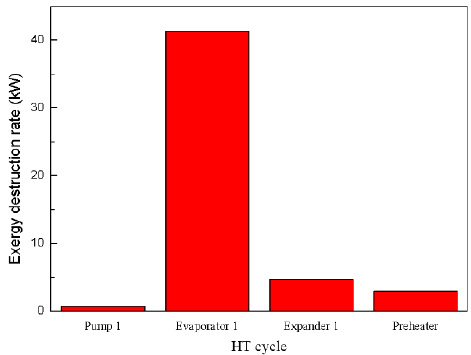
Figure 16. The exergy destructions rates of components in the HT cycle under the rated power output condition of the CNG engine.